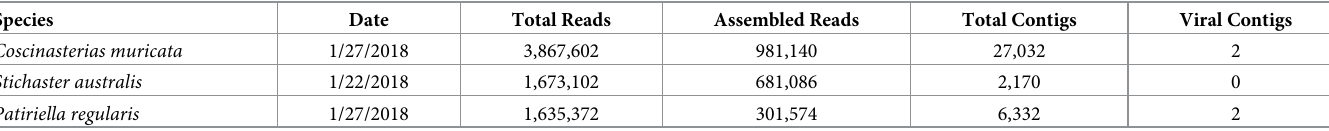
nell Biotechnology Resource Center. Sequences have been deposited in the NCBI under Table 2. Library characteristics prepared from asteroids in Northland and Auckland region, January 2018.